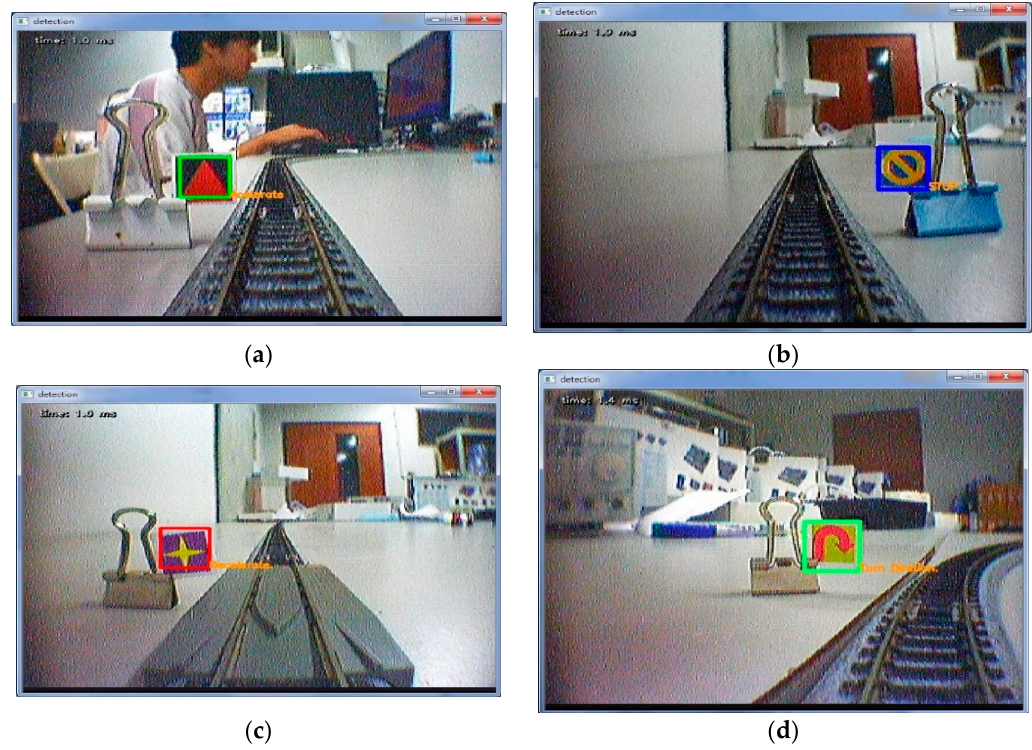
Figure 9. Confirmed detections of four predefined signs. ( a ) acceleration; ( b ) stop; ( c ) deceleration; ( d ) reverse.